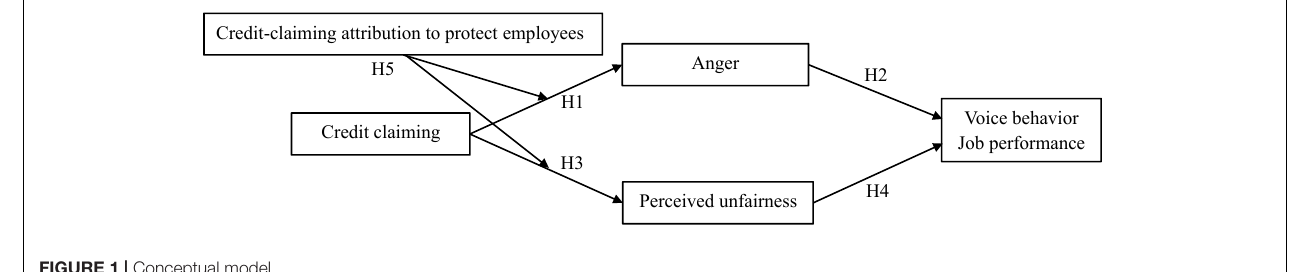
FIGURE 1 | Conceptual